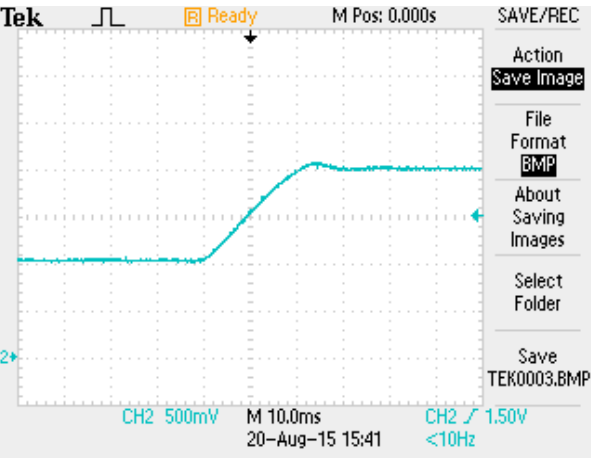
Figure 11. Step response of the power amplifier (current driver).